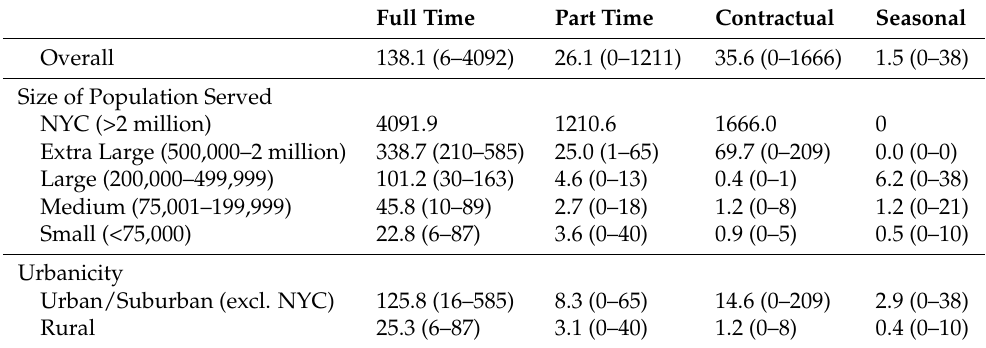
Table 2. Weighted Mean (Min-Max) Number of FTEs Employed, by Employee Type, LHDs in NYS